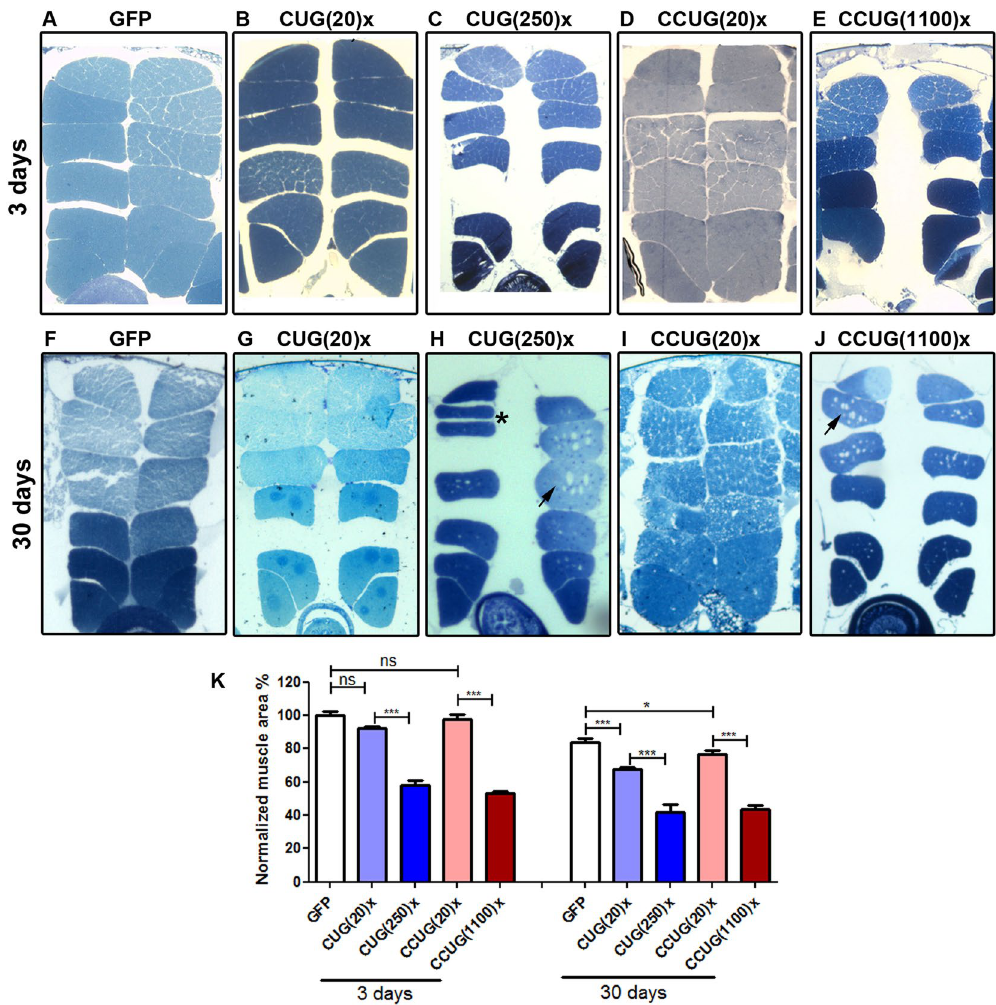
Figure 4. Expression of expanded CUG or CCUG repeats in muscle induces similar levels of muscle area reduction and degeneration. ( A – J ) Dorsoventral sections of resin-embedded fly thoraces. In all images the dorsal side is displayed at the top. Mhc-Gal4 was used to drive the expression of the indicated constructs in muscle. ( K ) Quantification of the mean percentage of muscle area per genotype relative to the muscle area of the control flies (GFP), which is considered as 100%. While young flies (3 day-old, in A – E ) expressing 20 CUG or CCUG repeats were not different from control flies expressing GFP, flies expressing expanded CUG or CCUG repeats have a 50% reduction in IFM muscle area. All aged flies (30 day-old, in F – J ) displayed reduced muscle area compared to young flies of the same genotype. However, vacuolization (arrows) and occasional muscle splitting (asterisk) characteristic of degenerating muscles were present only in muscles expressing expanded repeats. The graph shows the means ± SEM . * p < 0.05, ** p < 0.01, *** p < 0.001 (Student’s